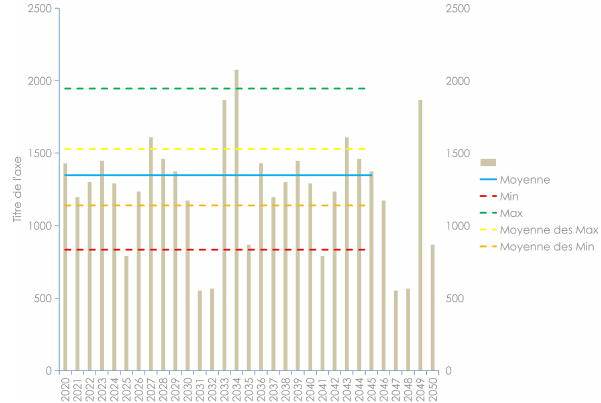
Figure 5. Précipitation annuelle depuis 2020 à 2050 (accessible à l’adresse suivante : https://climateknowledgeportal.worldbank.org/ download-data, la date du dernier accès : 18 octobre